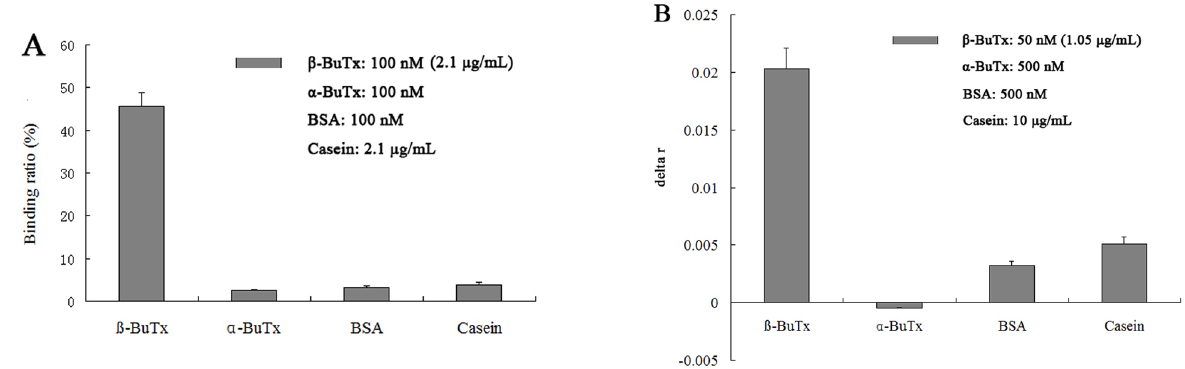
Figure 4. Binding affinity of the aptamer b B-1 to related proteins. A) Ten nM of fluorescein labeled b B-1 was mixed with 100 nM of b -BuTx, BSA, a -BuTx and 2.1 m g/mL of casein, respectively, and then nitrocellulose filter binding assay was performed to calculate the amount of b B-1 bound to tested protein; B) Two nM of fluorescently labeled aptamer b B-1 was mixed with 50 nM of b -BuTx and 500 nM of a -BuTx and BSA, and 10 m g/mL of casein, respectively, the anisotropy changes of b B-1 were determined. Values represent means 6 standard